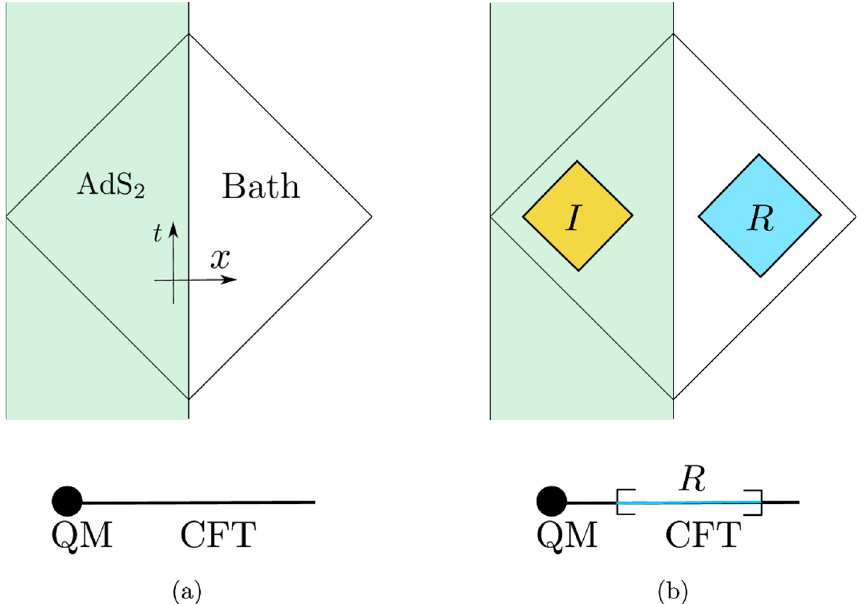
Figure 1 . (a) A zero temperature black hole in JT gravity coupled to bath. It has a nonperturbative description in terms of a boundary quantum mechanical system coupled to a CFT in half infinite space. (b) When we compute the entropy of a region R in the bath that is large enough, there will be an island I in the gravity